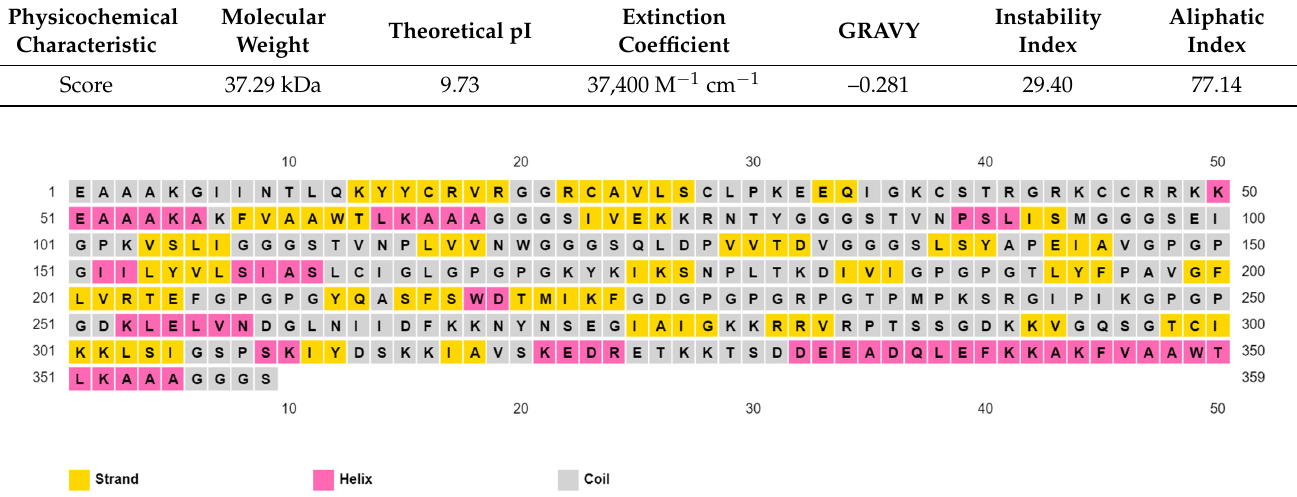
Table 8. Physicochemical characteristics of the designed multitope vaccine.